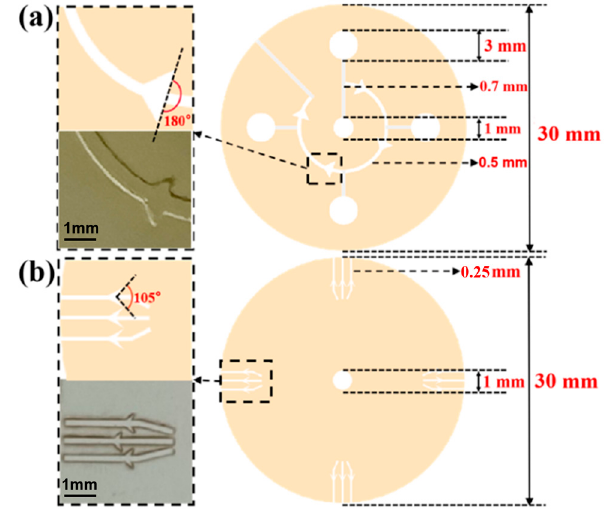
Figure 2. ( a ) The design drawing and size of sweat flow layer with CBV#1. The angle of CBV#1 at inlet is 180. The inlet of CBV#1 is a curved microchannel with 500 μ m width and 450 μ m height. ( b ) The design drawing and size of spiracle layer with CBV#2. The angle of CBV#2 at inlet is 105°. The inlet of CBV#2 is a rectangular microchannel with 250 μ m width and 50 μ m height.